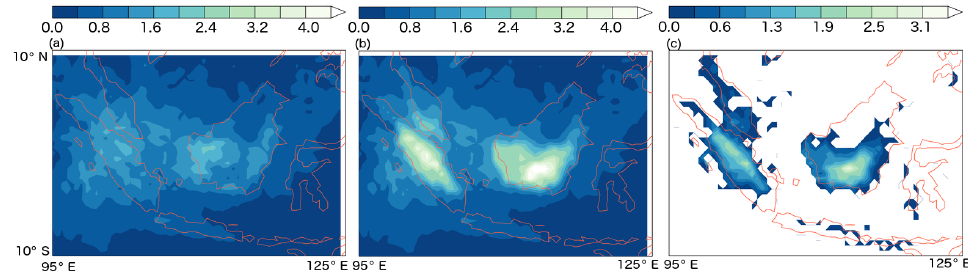
Figure 10. Spatial distribution of averaged AOD from the (a) the operational product, (b) the research product and (c) the differences of (b) minus (a) at 0.5 ◦ resolution over the study domain from August to October 2015.